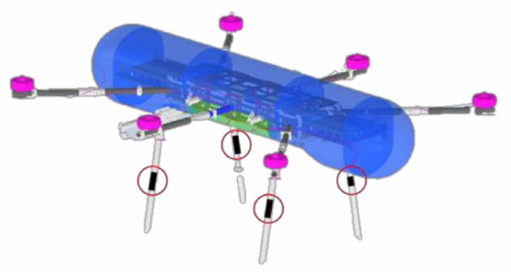
Figure 4. AEV markers for precise position correction of the mobile station.